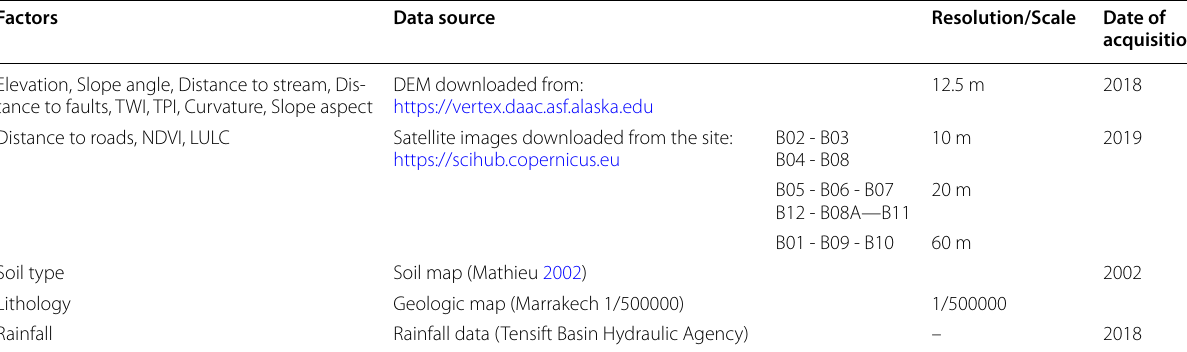
Table 1 Data sources used in the current study